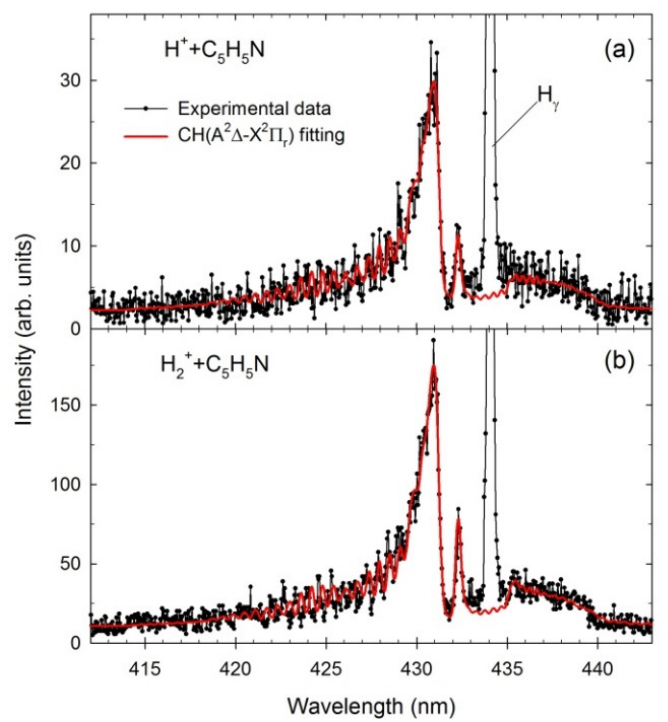
Figure 2. The experimental (black dots) and simulated (red contours) CH (A 2 Δ → X 2 Π r ) spectra obtained in the ( a ) H + + pyridine (E = 1000 eV), ( b ) H 2+ + pyridine (E = 1000 eV).